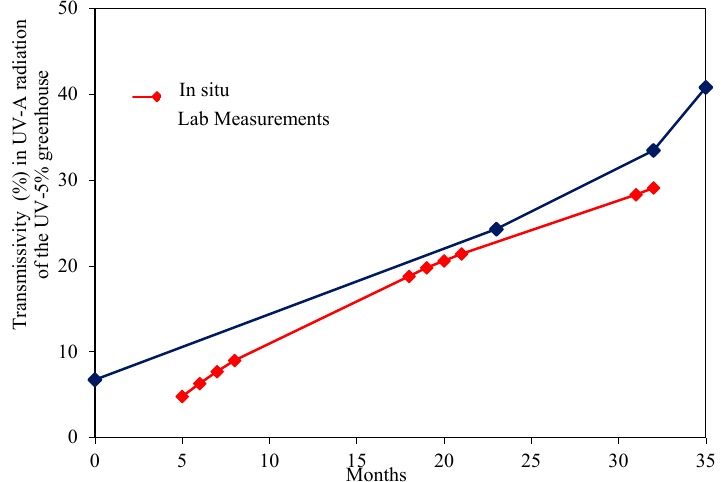
Figure 4. Comparison of laboratory measurements and in situ measurements for the UV-5% film in the UV-A region.